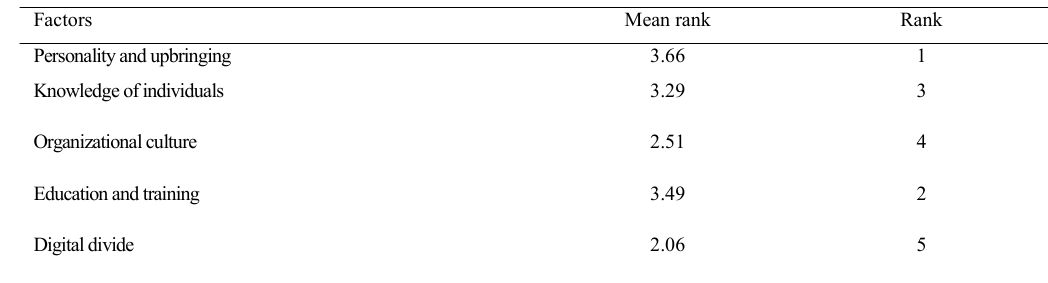
Table 4: Friedman